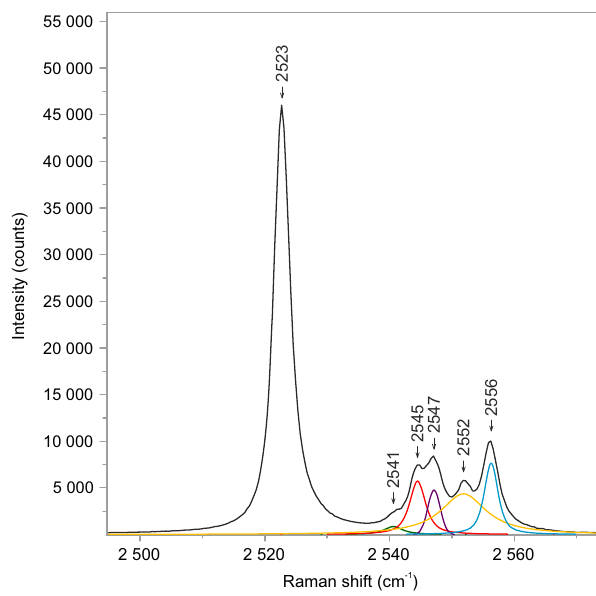
Fig. 7 Raman spectrum of solid H 2 S- γ in a natural CH 4 – H 2 S – CO 2 – N 2 – H 2 O fl uid inclusion (no. P4- fi 1B). Six characteristic peaks are observed in the H – S spectral region at − 191 °C. Five overlapping peaks have been deconvolved into separate bands and fi tted using the Gaussian – Lorentzian peak- fi tting function. The spectrum was acquired with 100% laser